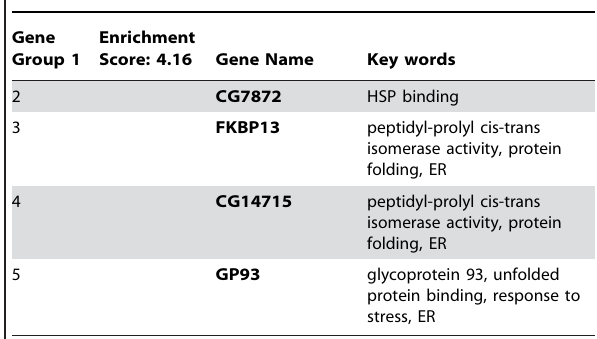
Table 4. Functional clustering of genes whose expression profiles stronlgy correlate with those of dLBR and CG1998 (using the DAVID classification tool at Medium